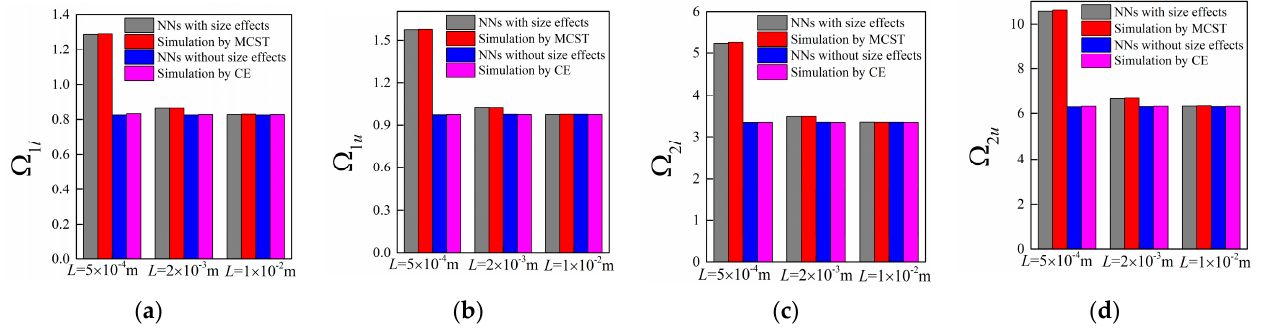
Figure 7. The predictions for bounding frequencies of size-dependent and size-independent band gaps of random example 3: ( a , b ) the lower and upper boundary of the first band gap; ( c , d ) the lower and upper boundary of the second band gap.